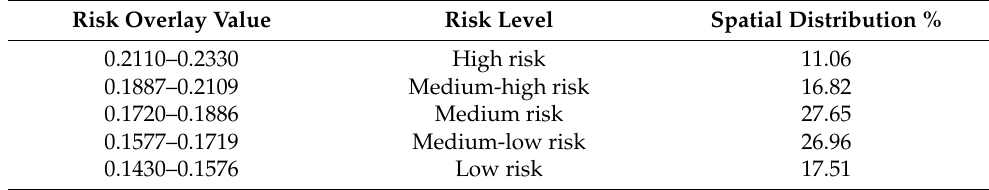
Table 4. Correspondence between risk overlay values and risk areas.